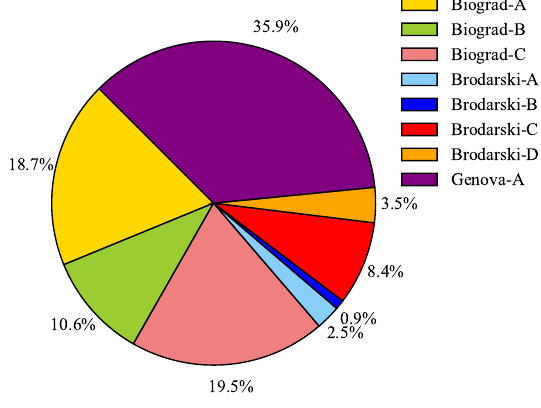
Figure 7. Samples distribution per scenario (True